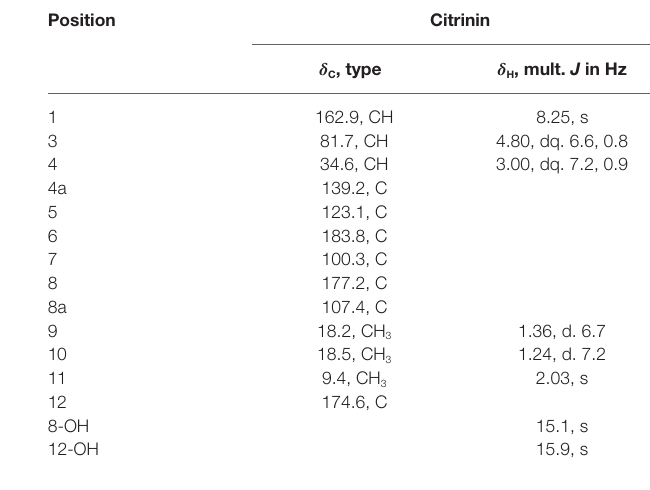
TABLE 3 | 1 H (400 MHz) and 13 C (100 MHz) NMR spectroscopic data for citrinin